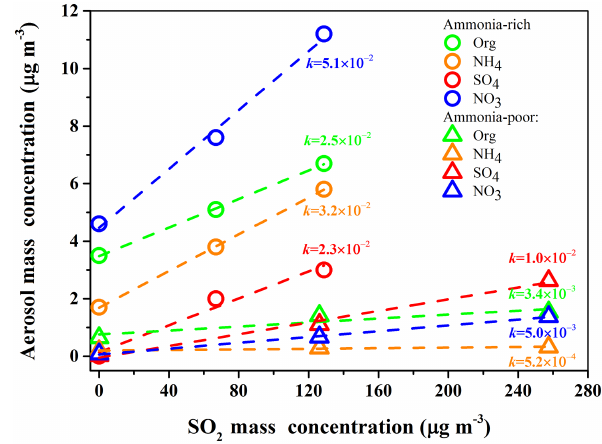
Figure 5. Formation of nitrate (blue), organic aerosol (green), sul- fate (red), and ammonium salt (orange) as functions of SO 2 con- centration in the photooxidation of toluene / NO x under NH 3 -rich (circles) or NH 3 -poor (triangles) conditions. The k values are the slopes of the fitted lines for each species. Experimental details are listed in Table